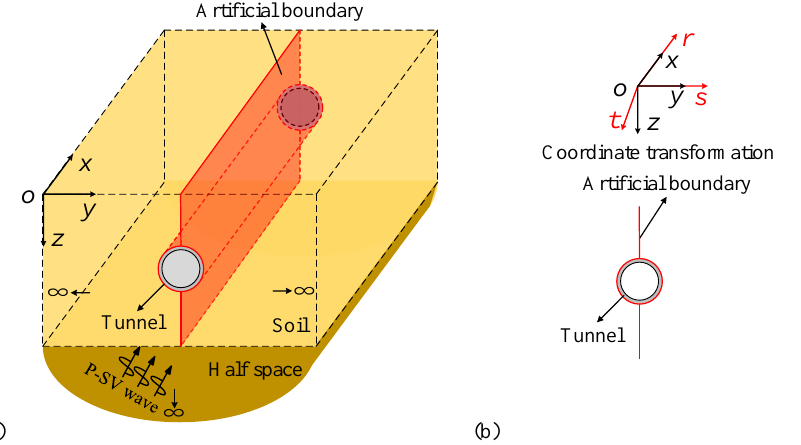
Figure 2. 2.5D soil–structure interaction model with oblique incidence of seismic wave. ( a ) The whole model, ( b ) substructure model.